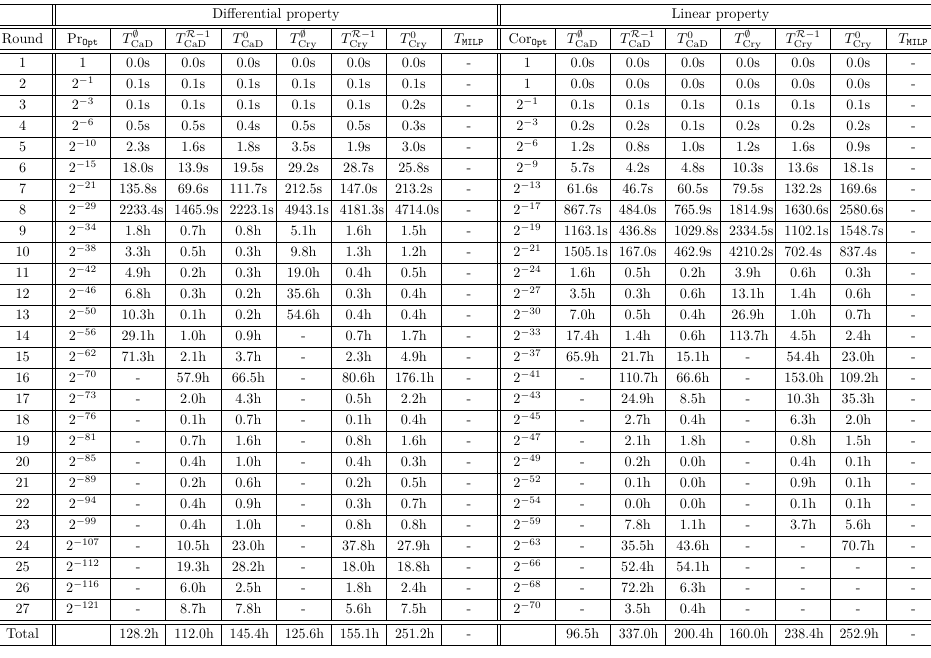
Table 19: Experimental results of SPECK64 .